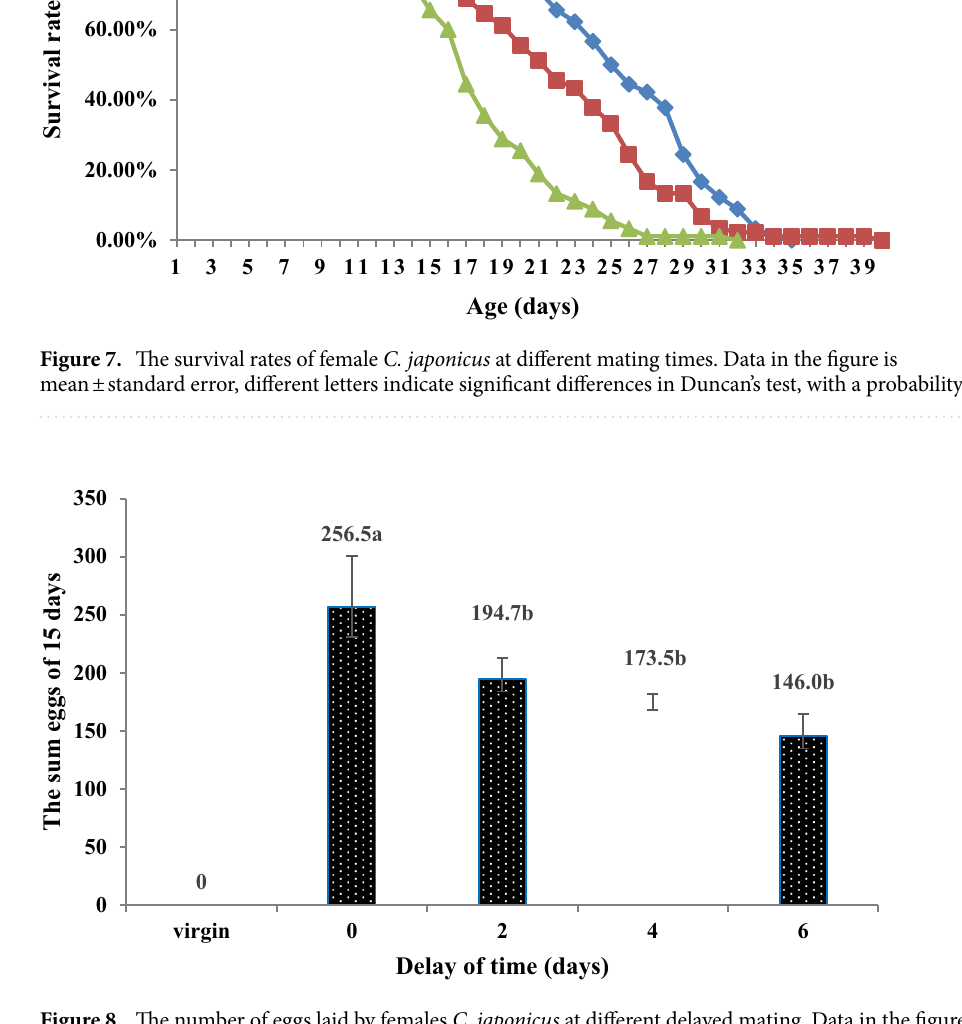
Some species of parasitoid wasps use lipids and proteins stored in the larval stage for egg development when only providing carbohydrates. In the absence of host parasitism, parasitoid wasps gain energy by resorbing eggs the female C. japonicus age were associated with reductions in the number of mature eggs (stage III), increases in the number of eggs at stage IV and reductions in the egg volume in the ovary, which indicated that egg resorption